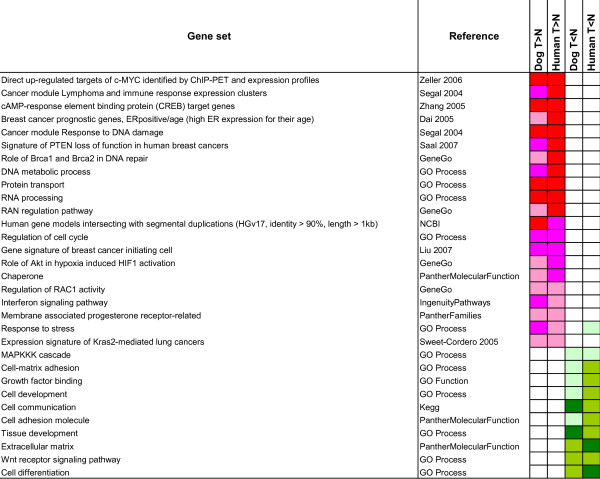
Gene set enrichment analysis of tumor deregulated genes. Results of gene set enrichment analysis carried out on the tumor deregulated genes independently identified in dog and human datasets. Enrichment p-values are computed using the Fisher's exact test. A selection of the gene sets enriched (p < 0.05) in both human and canine datasets is shown.